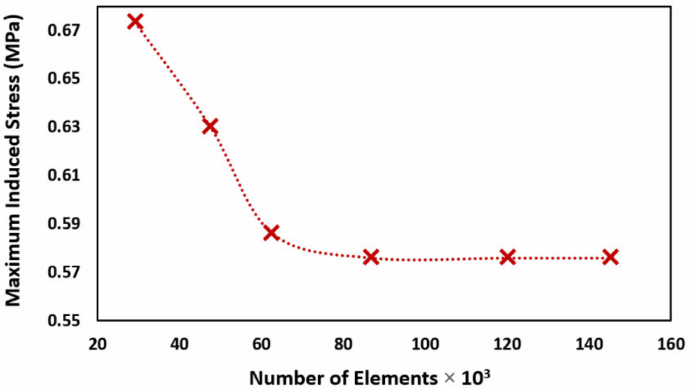
Figure 5. Mesh independence study for developed FE model using Altair